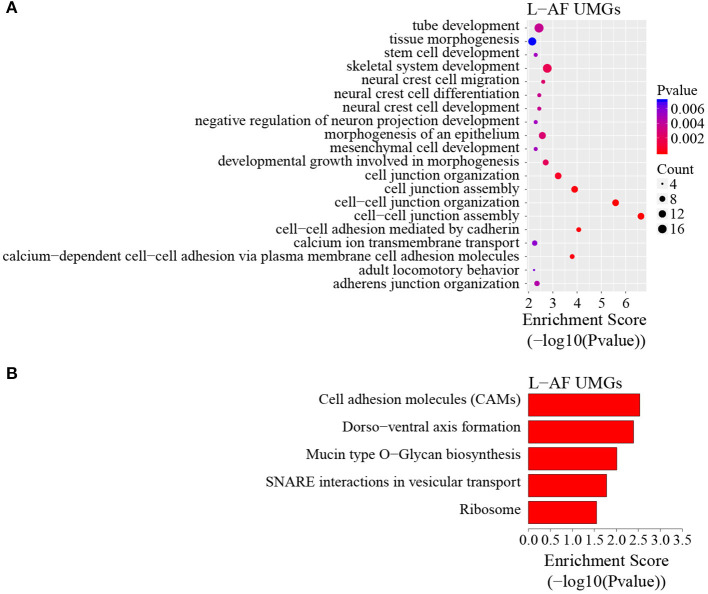
GO biological process and KEGG pathway analyses of unique m6A genes in lean-line broiler chickens. (A) GO analysis of unique m6A genes in the lean line (P < 0.05). (B) Pathway analysis of unique m6A genes in the lean line (P < 0.05).